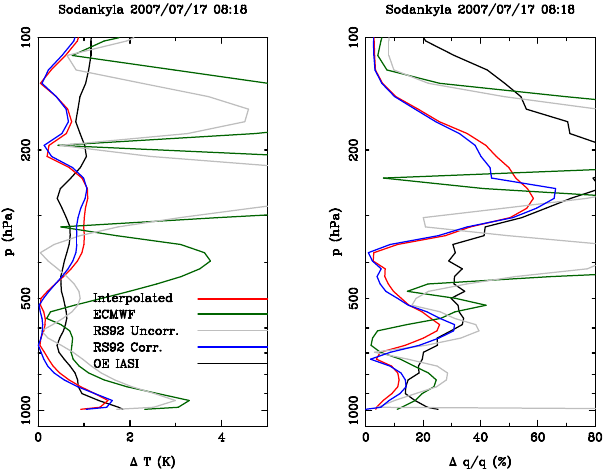
tion and adequacy errors ( (cid:49) ˆ x from Eq. 6) for the different reference